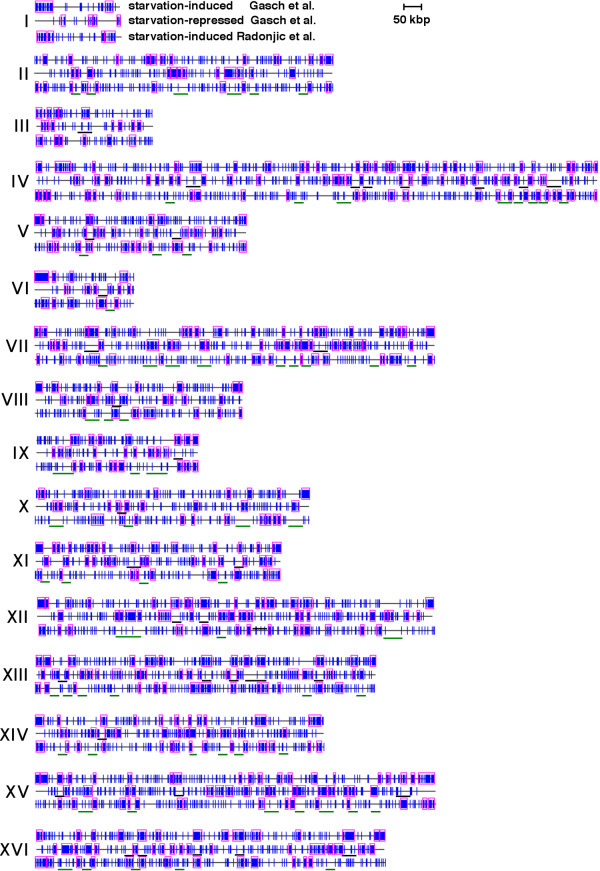
Chromosome maps of S. cerevisiae genes induced or repressed during 8h-28d nutrient depletion according to Gasch et al. (2000) [1] or induced by 20 hours of nutrient depletion according to Radonjic et al (2005). Vertical blue lines indicate the position of genes induced or repressed in these datasets. Pink rectangles indicate clusters of genes detected by Pyxis that are unlikely to have formed by chance (p ≤ 0.05). Roman numerals indicate chromosome number. Relatively gene-free gaps in clusters of starvation-repressed genes that coincide with the map positions of many starvation-induced genes and/or gene clusters are underlined in black. Relatively gene-free gaps in maps of starvation-induced genes that contain many starvation-repressed genes and/or gene clusters are underlined in green